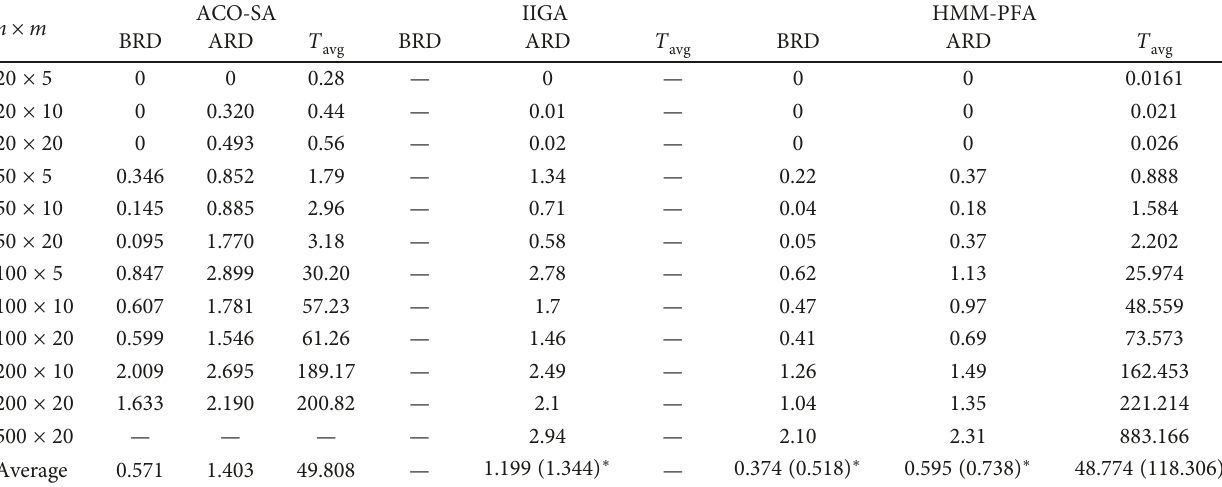
Figure 13: Gantt chart of the solution for Rec27. Table 6: Comparison of results based on Taillard ’ s benchmark